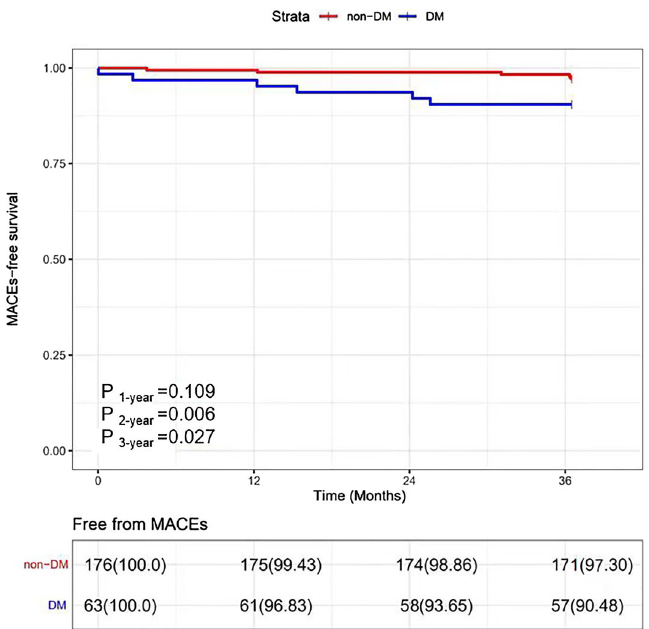
Figure 5. MACEs-free related to nCSA survival during the 3-year follow-up between DM and non-DM in phase